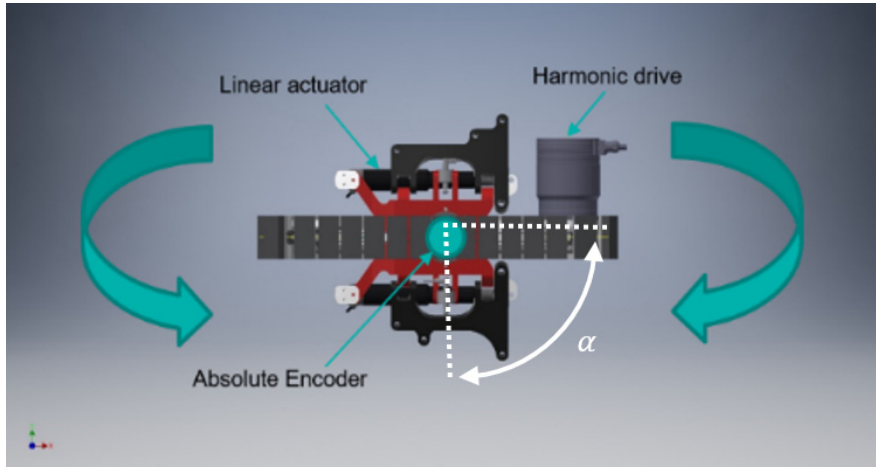
Figure 6. Top-view of the CRR crawler; arrows indicate steering axis.